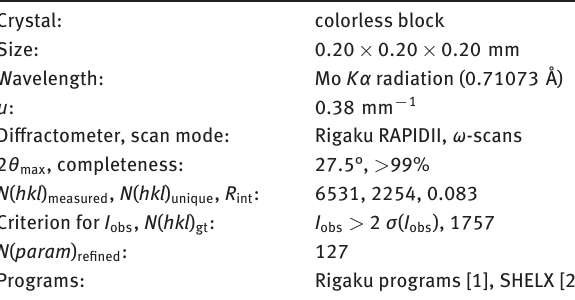
Table 1: Data collection and